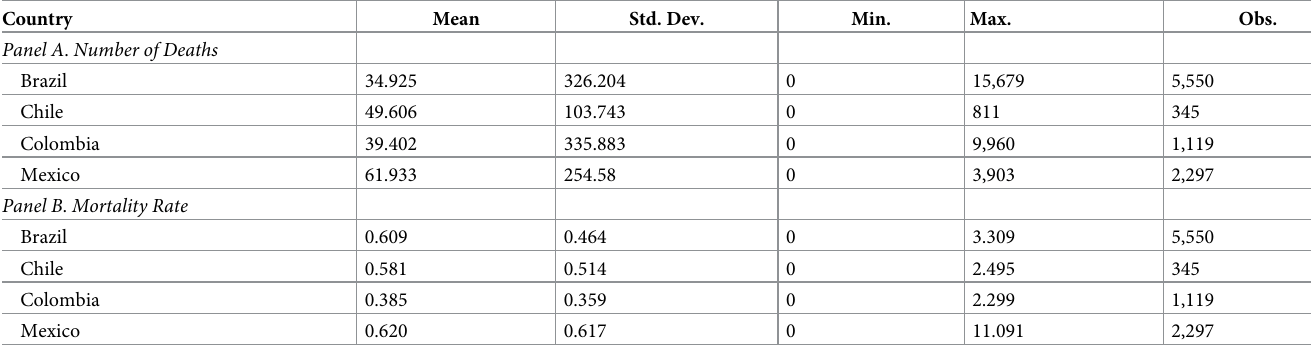
Table 1. Descriptive statistics on 2020 COVID-19 mortality by country.